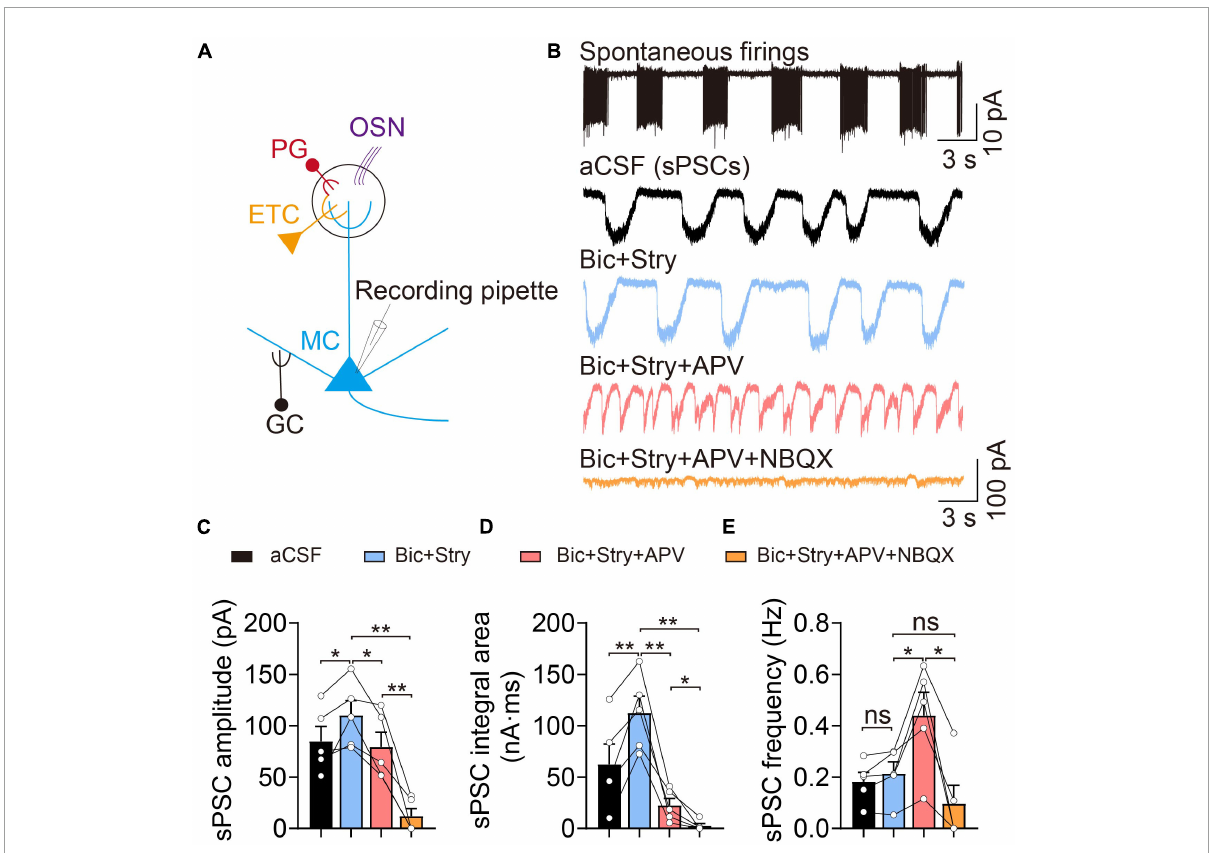
FIGURE1 Electrophysiological properties of mitral cells (MCs). (A) Basic representation of MC morphology and electrophysiological recording using the patch-clamp technique; olfactory sensory neuron (OSN, purple), external tufted cell (ETC, yellow), periglomerular cell (PG, red), and granule cell (GC, black). (B) Cell-attached recording of spontaneous burst firings (upper) and corresponding whole-cell recordings of spontaneous post-synaptic currents (sPSCs) in aCSF, Bic + Stry, Bic + Stry + APV, and Bic + Stry + APV + NBQX in the same MC. (C–E) sPSC amplitude, integral area, and frequency in aCSF, Bic + Stry, Bic + Stry + APV, and Bic + Stry + APV + NBQX. Elevated sPSC amplitude and integral area in the presence of Bic + Stry and inhibition of sPSC by APV and NBQX revealed that the excitatory inputs in MC are regulated by glutamate receptors involving NMDA and AMPA receptors. Error bars represent standard error; * p < 0.05, ** p < 0.01; ns, not significant; one-way ANOVA with LSD post-hoc